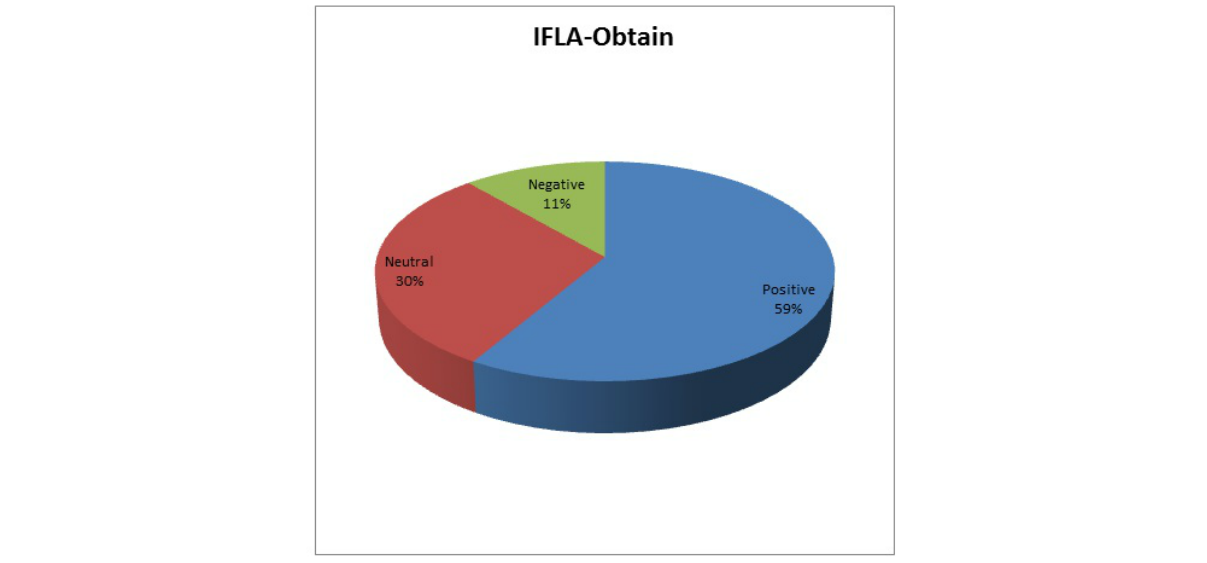
Figure 8. Users' responses mapped to the IFLA-Obtain